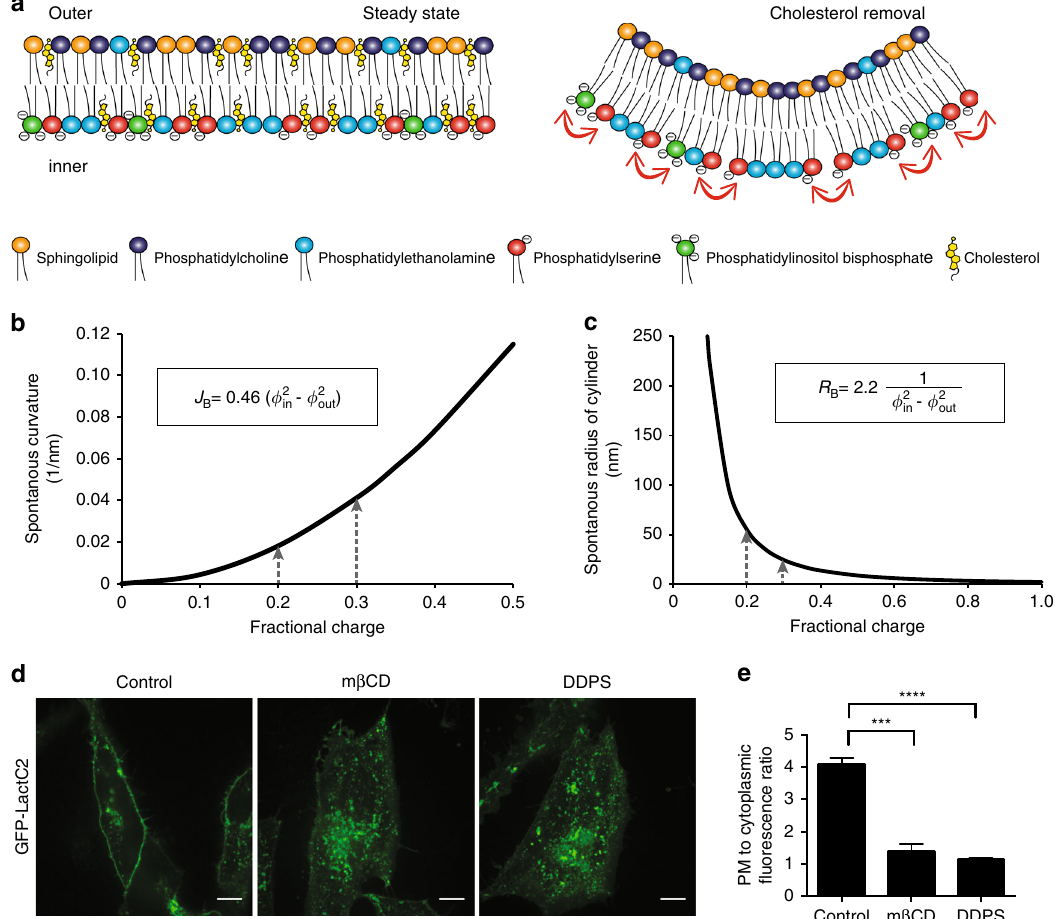
Fig. 4 Increased charge density magni fi es spontaneous curvature. a A diagram depicting a model membrane featuring phospholipids before (left) and after (right) cholesterol extraction. The color of the headgroup corresponds to each phospholipid, and the arrows indicate headgroup charge repulsion. b Spontaneous bilayer curvature predicted theoretically. J B , a spontaneous curvature of a bilayer (nm); Φ in , fraction of charged lipids in the inner monolayer and Φ out , fraction of charged lipids in the outer monolayer. c Calculated spontaneous preferred cylinder radius ( R B ) of a bilayer with varying fraction of charged lipids in the inner monolayer. d HeLa cells expressing the GFP-LactC2 probe were incubated with 10 mM m β CD or supplemented with 30 μ M DDPS for 15 min and imaged using confocal microscopy. e Quantitation of the ratio of PM to cytoplasmic GFP-LactC2 in control cells, m β CD- or DDPS-treated cells. NS = not signi fi cantly different, *p < 0.05, **p < 0.01, ***p < 0.005 and ****p < 0.001; as determined using a two-tailed t-test. Values represent means ± s.e.m., n =